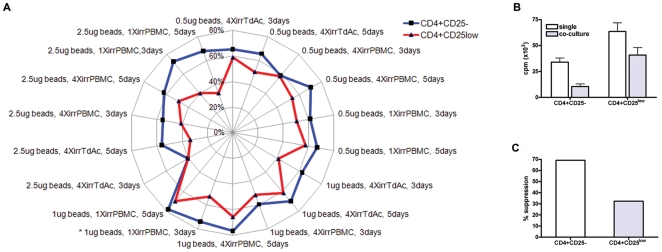
CD4+CD25low T cells were suppressed less than CD4+CD25- in in vitro co-culture with Tregs.A) The percentage of suppression for CD4+CD25- (blue, outer line) and CD4+CD25low T cells (red, inner line) as responders in co-culture with Treg (Tresponder:Treg  =  1∶1) for 3 or 5 days with 18 different combinations of stimuli. The suppression difference is most statistically significant when the type of responder T cells differ (p<0.003, n = 6) irrespective of type of APC or duration and strength of stimuli. Asterisk (*) indicates conditions chosen for experiments that followed. B) Presented are cpm and standard errors for conditions with asterisk in Figure 3A. C) Percentages of suppression for conditions shown with asterix in Figure 3A are presented.